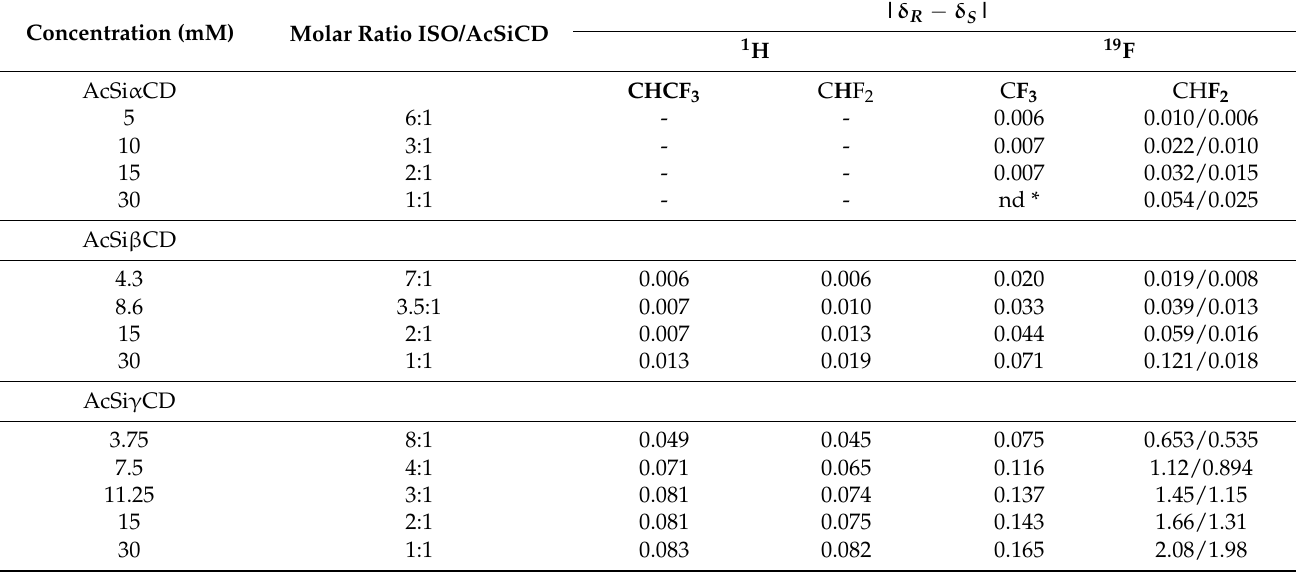
Table 1. 1 H (600 MHz, C 6 D 12 , 25 ◦ C) and 19 F (564 MHz, C 6 D 12 , 25 ◦ C) NMR non-equivalences (| δ R − δ S |, ppm) measured for ISO (30 mM) resonances in the presence of AcSi α CD, AcSi β CD or AcSi γ CD at different molar